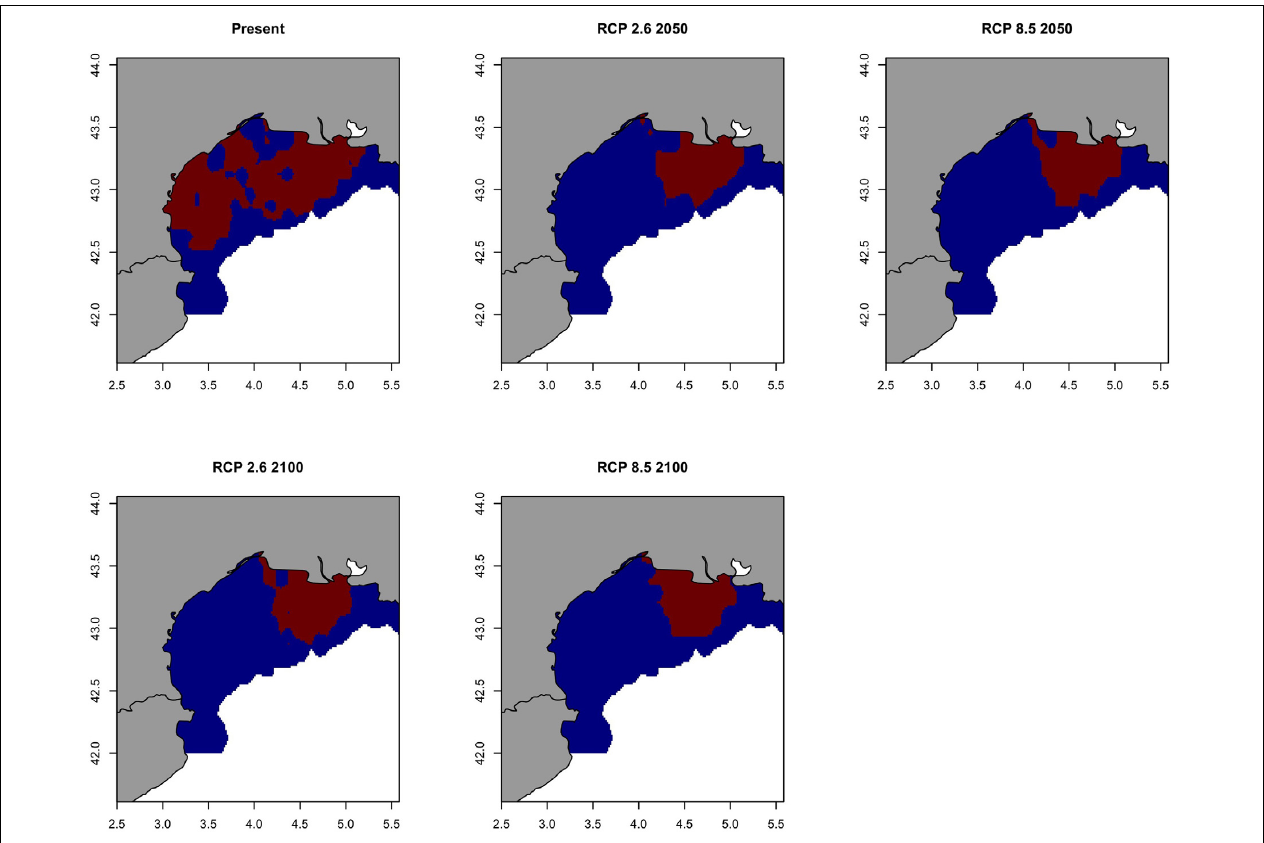
FIGURE 15 | Climate refuges, hot-spots of the probability of occurrence ( > 0.7) of the European anchovy ( Engraulis encrasicolus ) in Geographical Sub-Area 07 for the present situation and using IPCC pathway scenarios obtained with RAC-BRT models. Red color indicates probability of occurrence > 0.7, while blue <